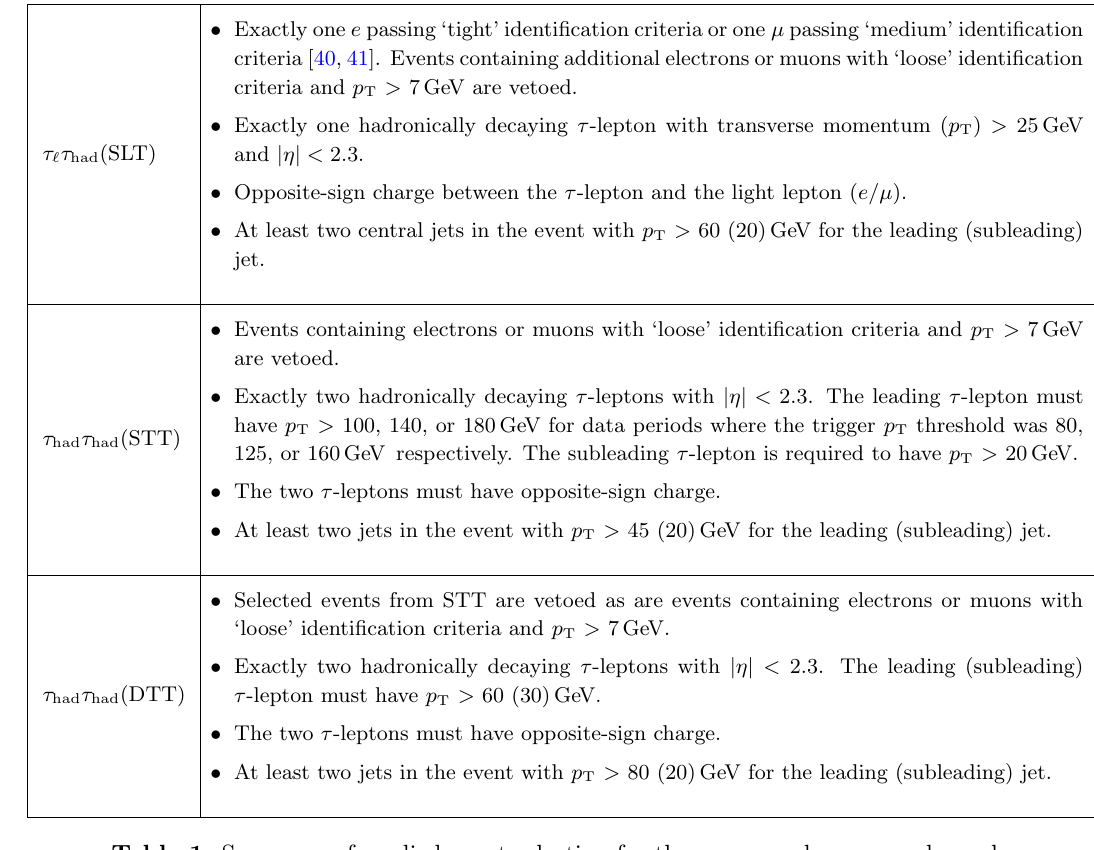
Table 1 . Summary of applied event selection for the (cid:28) ‘ (cid:28) had and (cid:28) had (cid:28) had channels. (cid:15) m : the invariant mass between the lepton and its matching jet from the ‘; jet